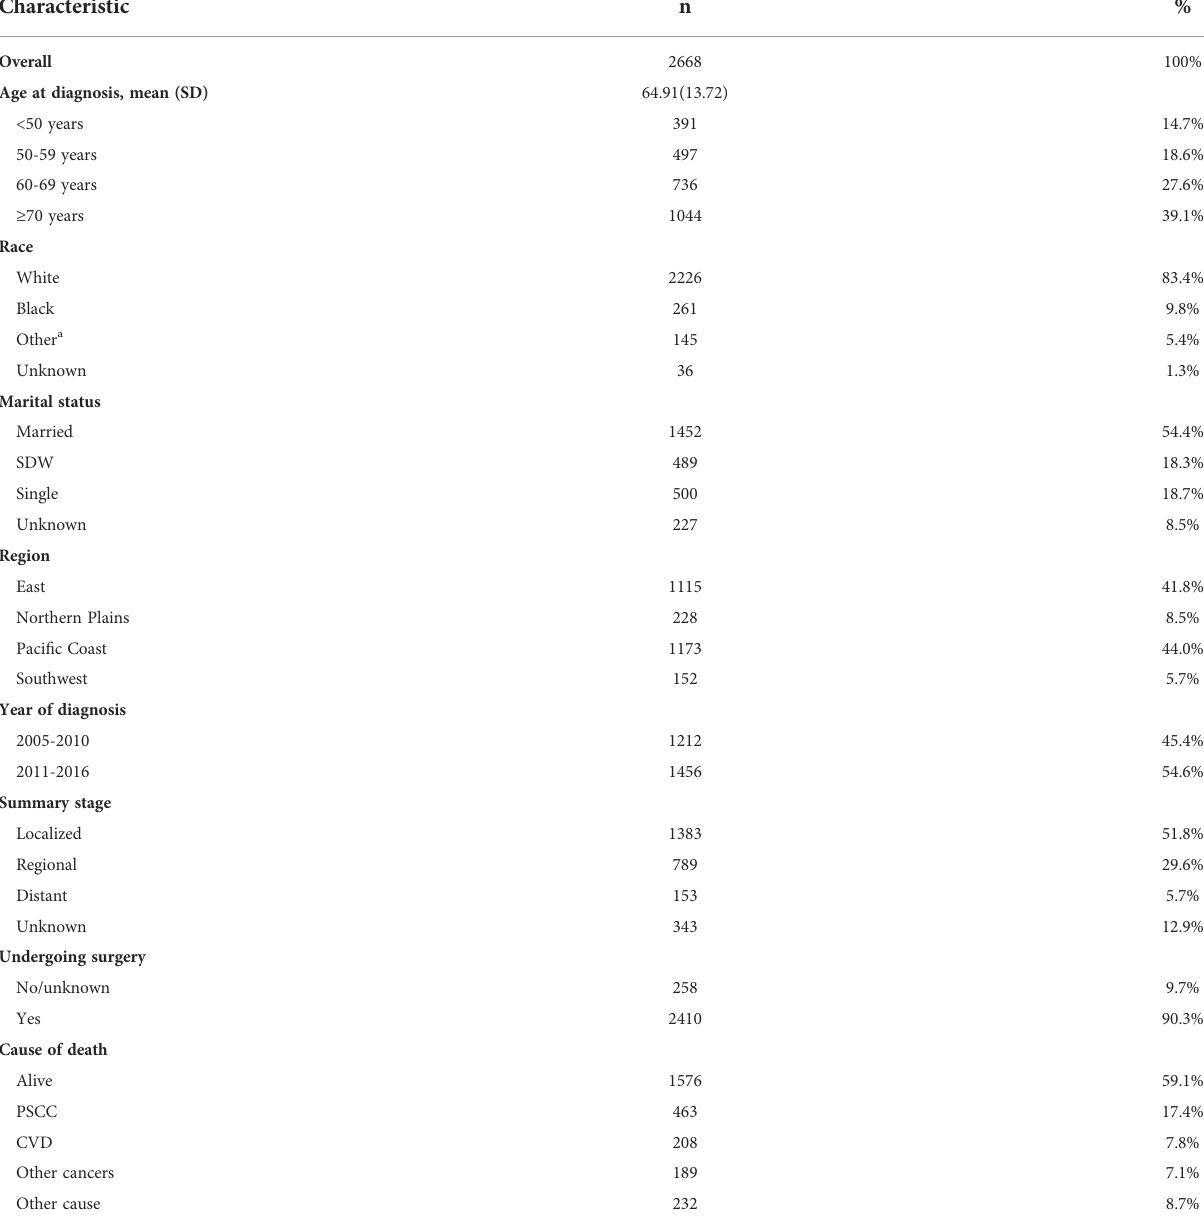
TABLE 1 Description of population-based cohort of men with